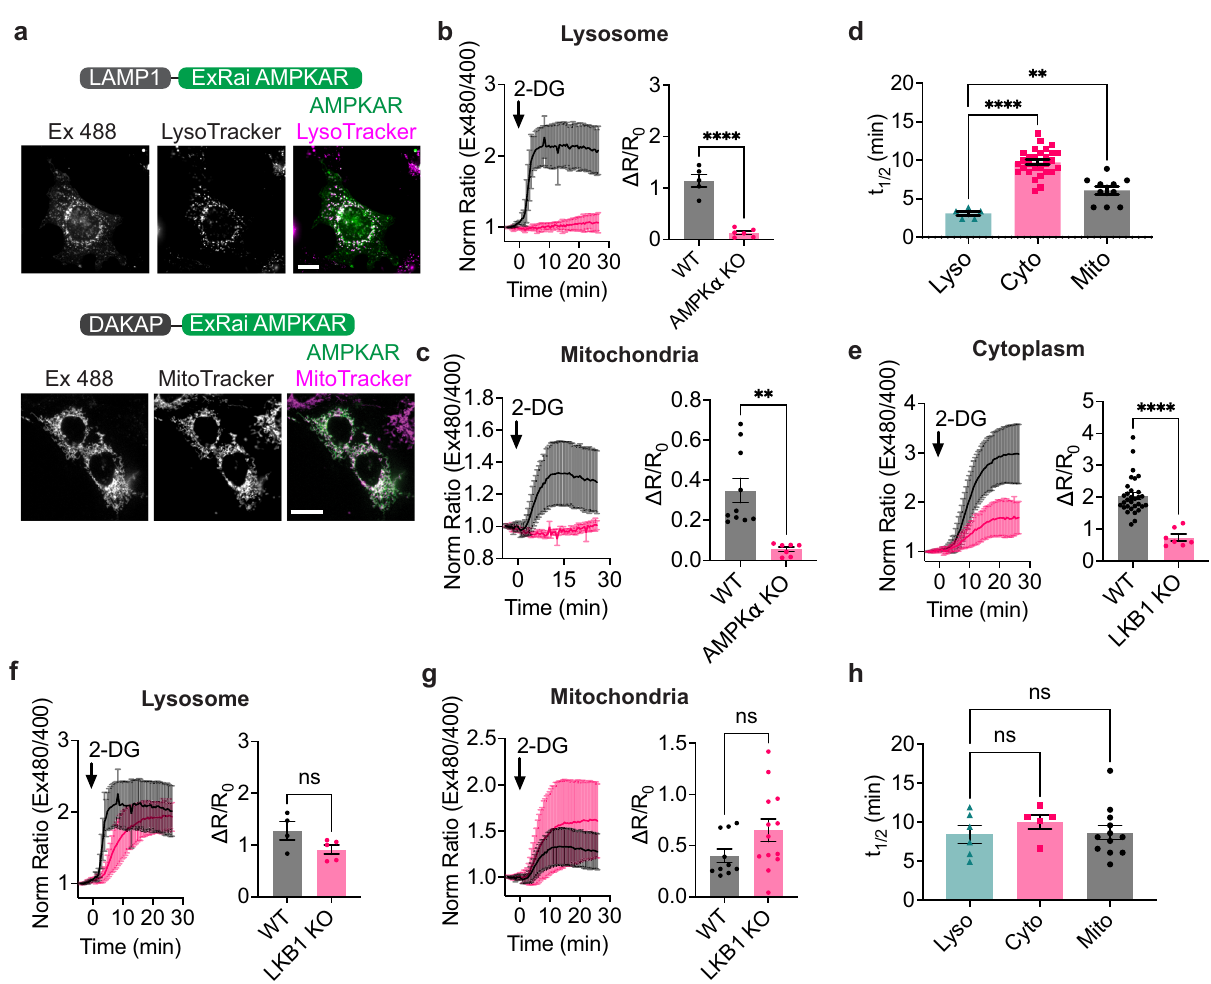
Fig. 2 Lysosomal AMPK activity is rapidly induced in an LKB1-dependent manner. a (Top) Domain layout and representative image of lyso-ExRai AMPKAR in MEFs stained with the lysosomal marker LysoTracker Red. (Bottom) Domain layout and representative image of mito-ExRai AMPKAR in MEFs stained with the mitochondrial marker MitoTracker Red. b Average response of lyso-ExRai AMPKAR in WT (black, n = 5 cells from two experiments) and AMPK α KO MEFs (pink, n = 6 cells from two experiments) to 2-DG (40 mM) stimulation, along with maximum ratio change ( p = 9.66 × 10 − 6 , unpaired t - test, two-tailed). c Average response of mito-ExRai AMPKAR in WT (black, n = 10 cells from fi ve experiments and AMPK α KO MEFs (pink, n = 7 cells from three experiments) treated with 2-DG (40 mM) along with maximum ratio change (** p = 0.0012, unpaired t -test, two-tailed). d Time to half-maximal response ( t 1/2 ) of lyso-ExRai AMPKAR (teal), cytoplasmic ExRai AMPKAR (pink), and mito-ExRai AMPKAR (black) following treatment with 2-DG (** p = 0.0033; **** p = 4.43 × 10 − 10 , one-way ANOVA with Dunnett ’ s multiple comparisons test). e Average response to 2-DG (40 mM) stimulation of cytoplasmic ExRai AMPKAR in WT (black, reproduced from Fig. 1e) and LKB1 KO MEFs (pink, n = 7 cells from four experiments), along with